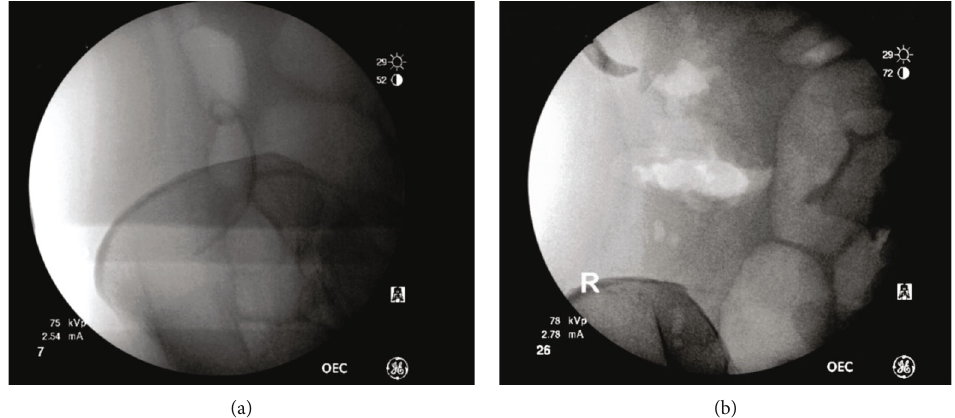
Figure 3: Diagnostic laparoscopy evaluation with fl uoroscopic guidance was performed to locate the exact positioning of the pigtail catheter within the cecum before surgery (a) and after pigtail catheter removal (b).